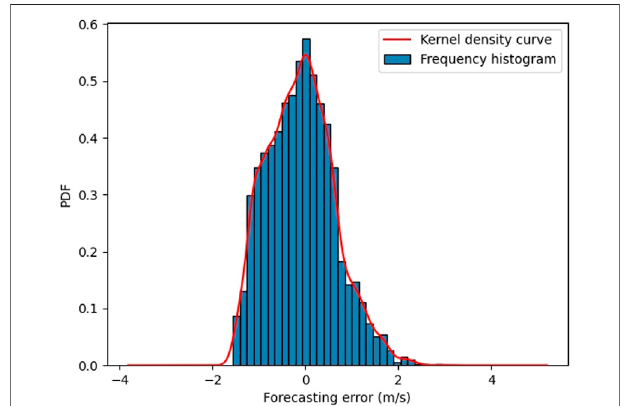
FIGURE 8 | PDF of predicted error within spring.